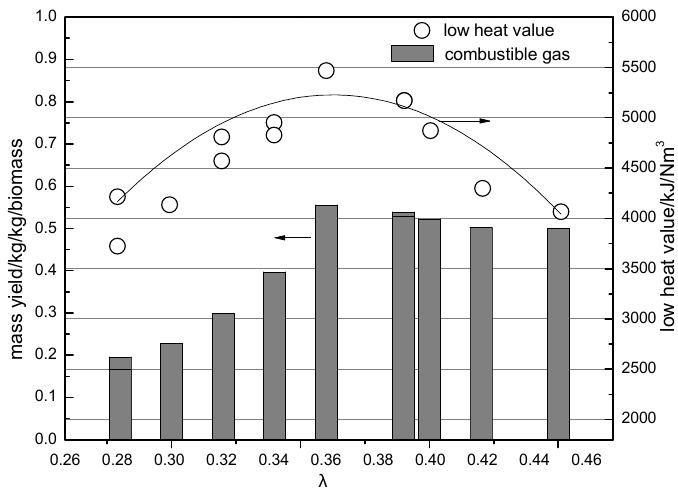
Figure 9. Mass of combustible gas and low heat value of syngas.